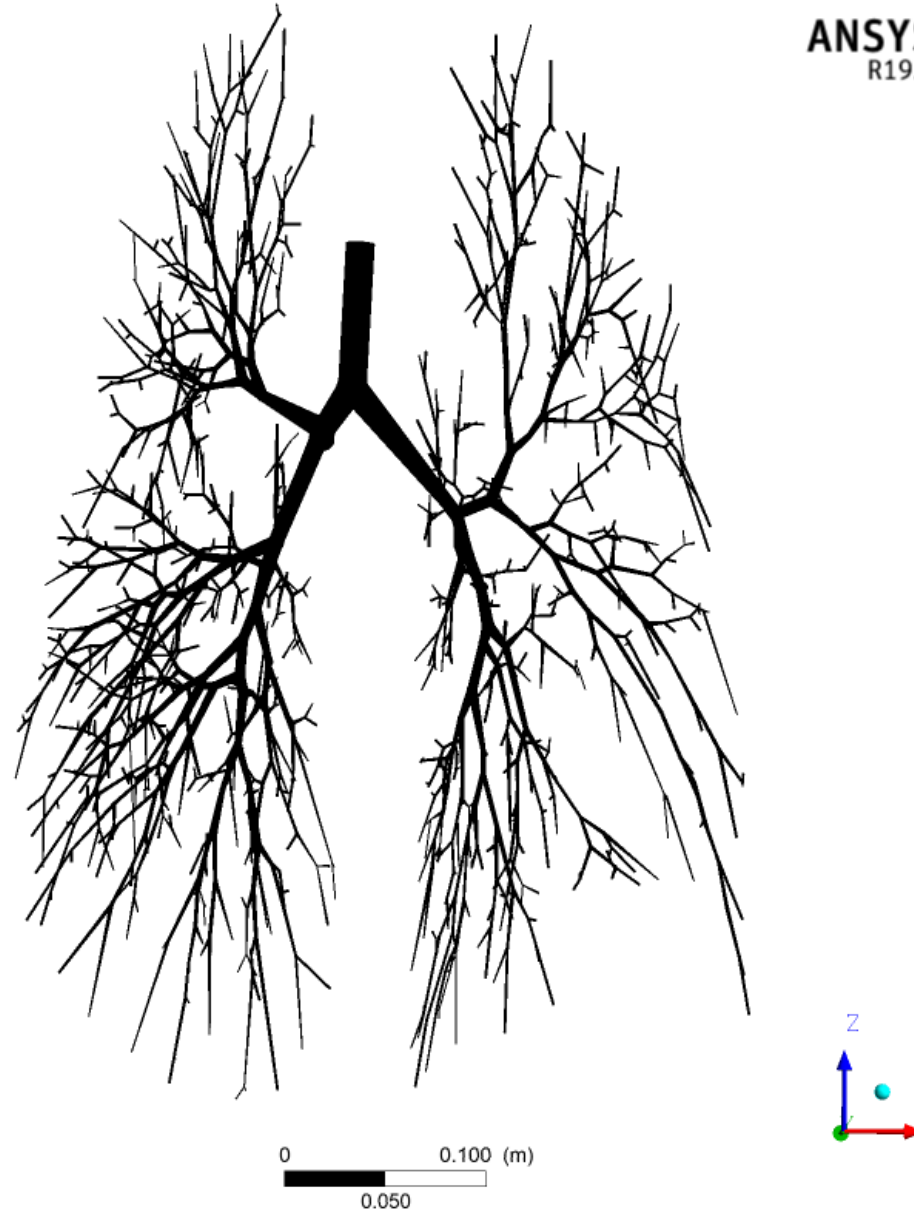
Figure 2. Computational domain of the G0–G17 human conducting airways with 720 bronchi out- lets.